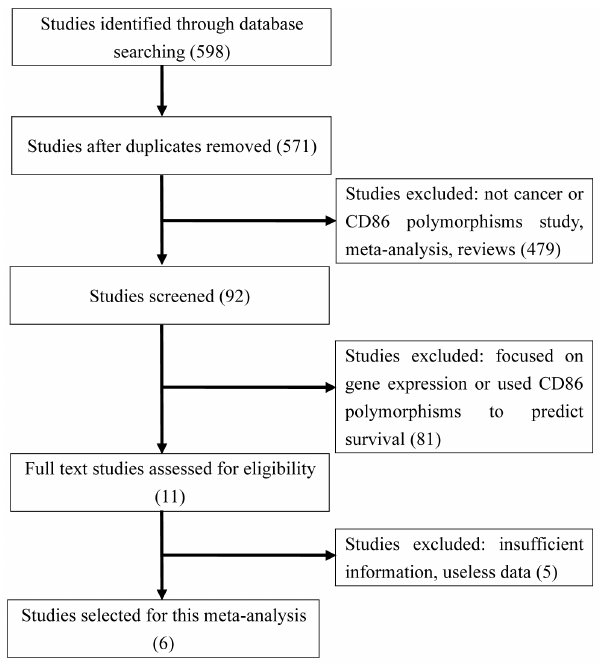
Figure 1. Flow diagram of studies identification.